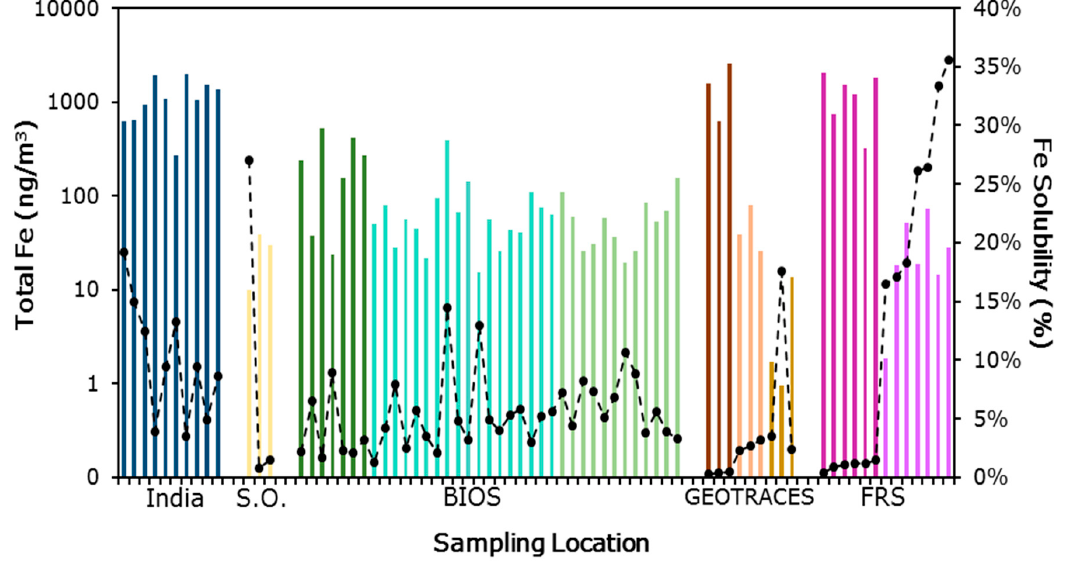
Figure 2. The total iron (colored bars, in ng/m 3 ) and soluble iron (dashed black line, in %) are shown for each sample set, where each sample set and air mass source region are color coded as follows: India , Southern Ocean (S. O.) , BIOS Saharan air masses , BIOS mixed air masses